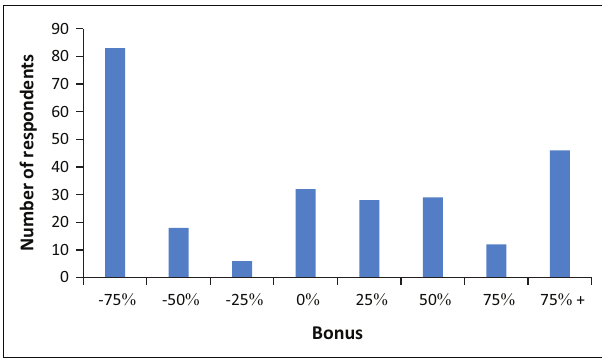
FIGURE 2: Frequency distribution for the level of bonus for which an employee would consider moving to another organisation with a perceived strong employer brand.